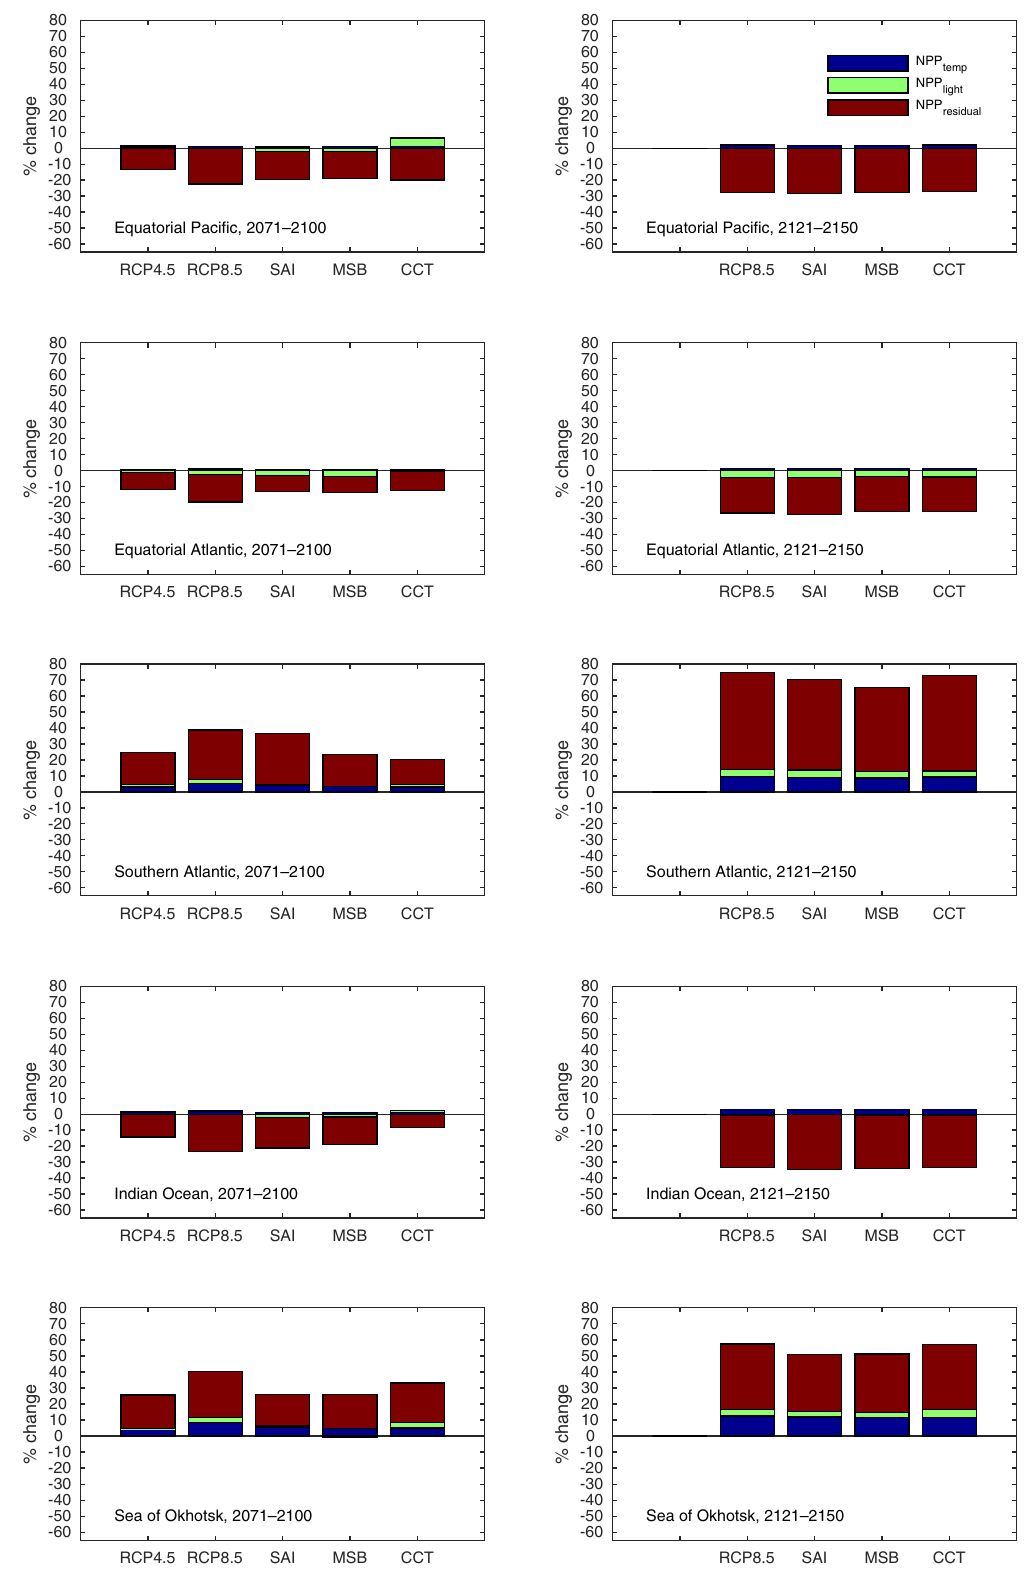
Figure 9. Offline-calculated NPP change (%) in five different regions (as indicated in Fig. 6b) for RCP4.5, RCP8.5, and RCP8.5 with three different RM methods. The residual (NPP total − NPP temp − NPP light ) represents the circulation-induced